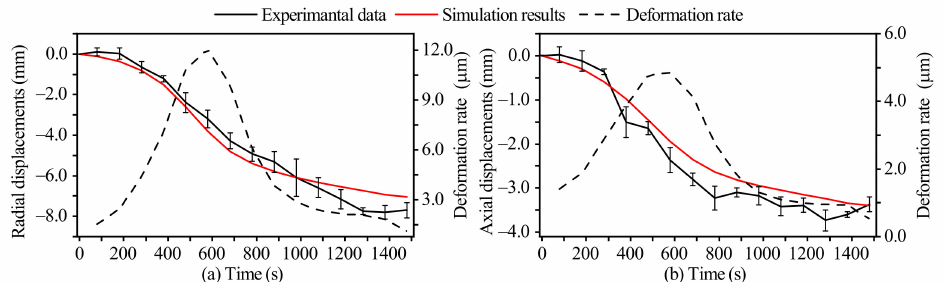
Figure 5. Radial and axial displacements. ( a ) Radial displacements and deformation rate. ( b ) Axial displacements and deformation